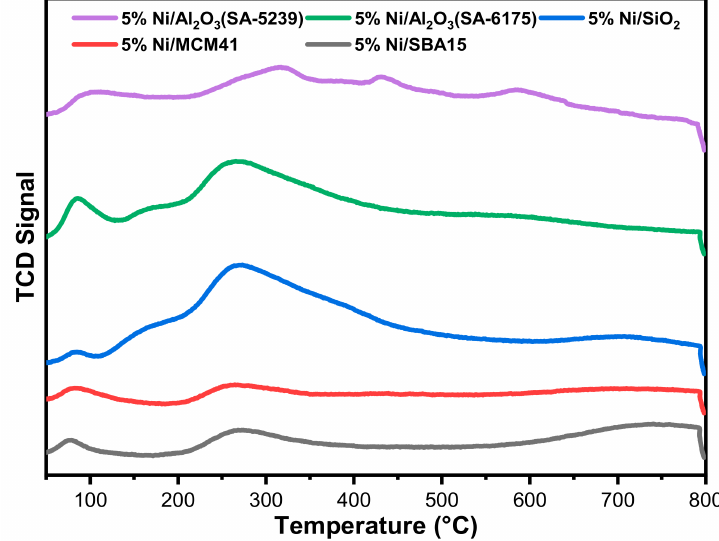
Figure 4. CO 2 -Temperature Programmed Desorption (CO 2 -TPD) profiles for the freshly calcined